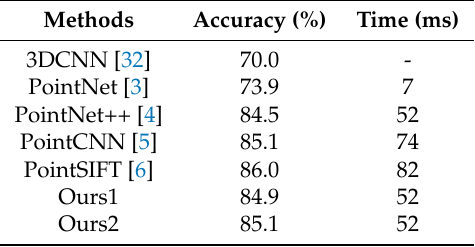
Table 1. Comparison of time and precision of different